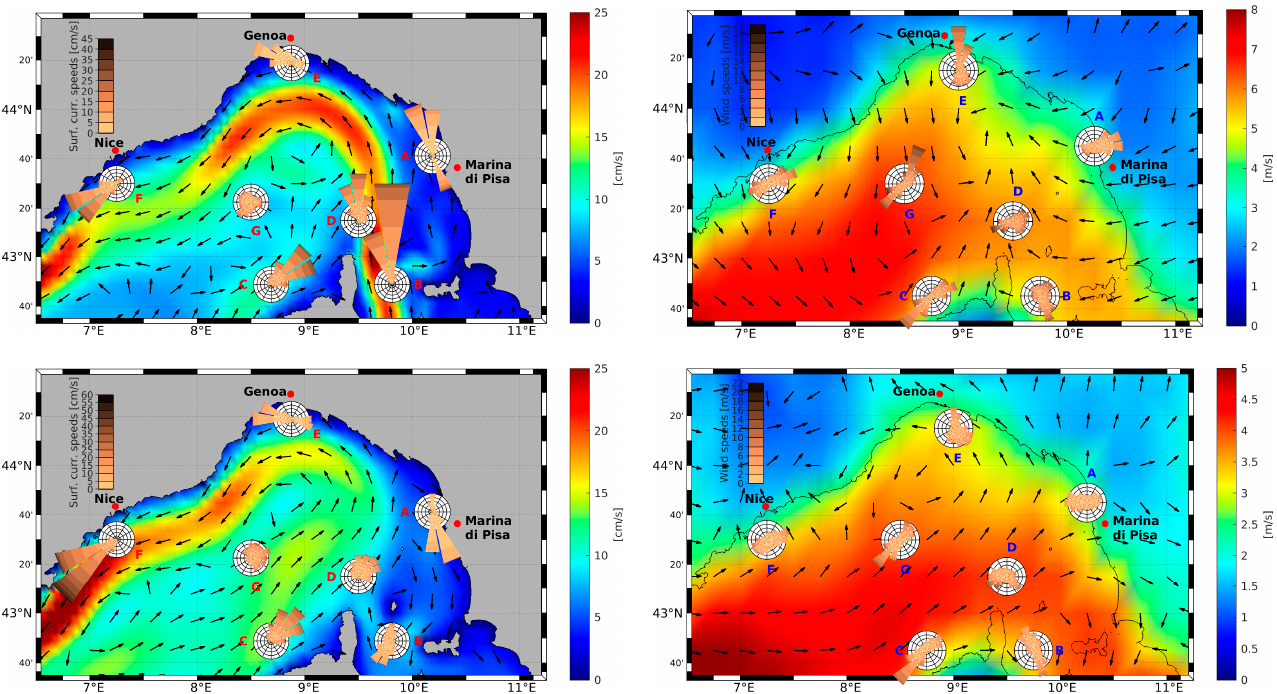
Figure 2. Left column: rose plots of seasonal surface currents speeds and directions (towards) superimposed to seasonal surface circulation pattern (upper panel: winter, lower panel: summer). Right column: rose plots of seasonal wind speeds and directions (from) superimposed to seasonal wind pattern (upper panel: winter, lower panel: summer). Concentric rings in rose plots represent the direction distribution with values ranging from 2% to 10%, with a 2% interval between each other. Cardinal directions are represented by 16 radiating spokes. Please note that different color bars are used in the panels. Labels from A to G define the following locations or surface circulation features. A: Arno River outlet area; B: eastern Corsica current (ECC); C: western Corsica current (WCC); D: merging of the ECC and WCC; E: northernmost portion of the Liguro–Provençal–Catalan current (LPC) in the Liguro–Provençal basin (LPB); F: easternmost portion of the LPC in the LPB; G: approximate center of the LPB.